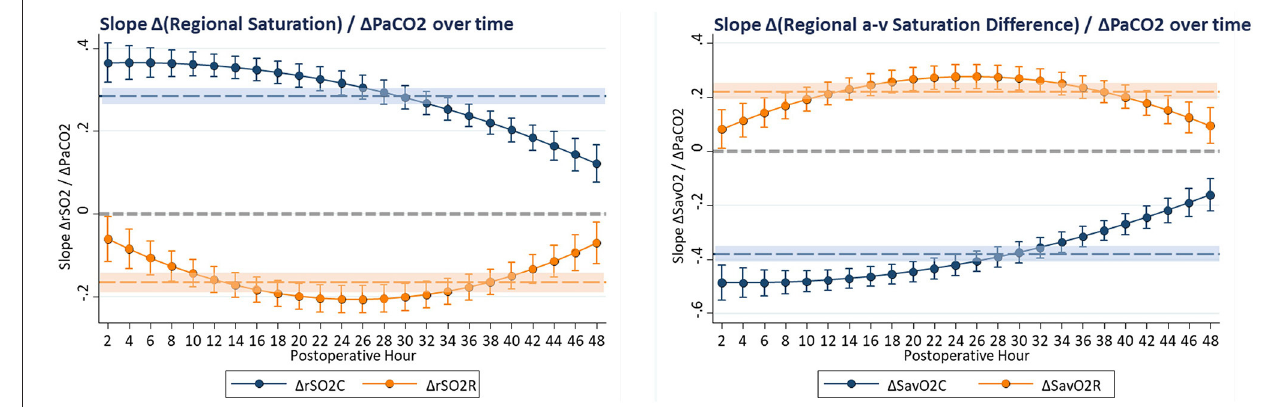
FIGURE 4 | The slope of change in regional oxygenation or arteriovenous difference vs. change in PaCO2 was computed at hourly intervals from multivariable models. Covariates were constrained to clinically realistic values near the observed means (SaO2 = 83%, MABP = 51 mmHg, Hb = 15 gm/dl, CVP = 10 mmHg,